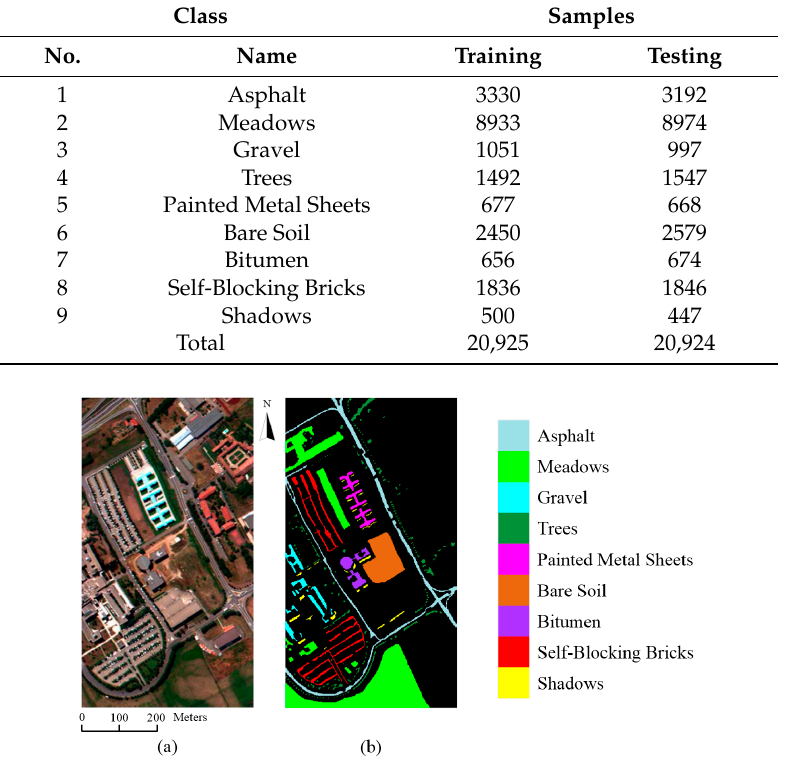
Table 1. Color coding and sample size for Pavia University scene.